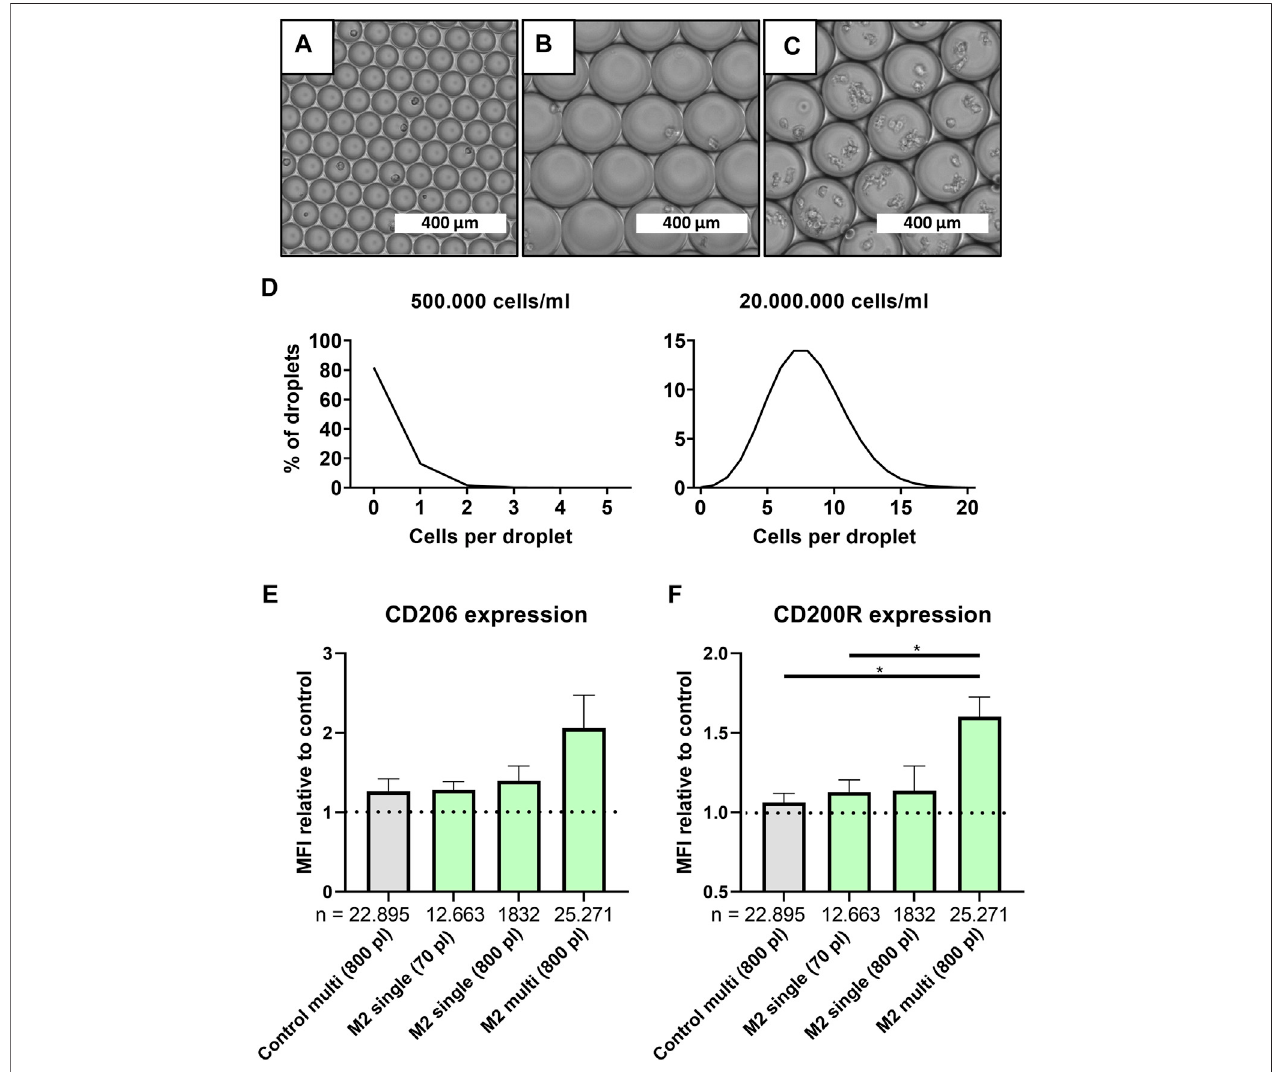
FIGURE 3 | Multi-cell droplets to model cell-cell interactions in droplets. (A – C) Light microscopy picture of small single-cell droplets ( ∼ 70 pl), large ( ∼ 800 pl) size single-celldropletsandlargemulti-celldroplets,scalebarsrepresents400 μ m. (D) Predictedcelldistributionin ∼ 800 pldropletsascalculatedbyPoissondistributionfor single-celldroplets(500.000 cells/ml)andmulticelldroplets(20.000.000 cells/ml). (E,F) MFIrelativetosingle-cellcontrolsamplesforCD206andCD200R,respectively, for samplescultured in800and 70 pldropletswithsingle-ormulti cellencapsulation.Grey bar represents unstimulatedmulti-cellcontroland green barsrepresent M2 stimulated samples of three unique donors. “ n ” indicates number of cells measured from all donors combined. Statistical signi fi cance was tested using repeated- measures one-way ANOVA with post-hoc Tukey ’ s test where * p < 0.05. If no signi fi cance is indicated, it was not